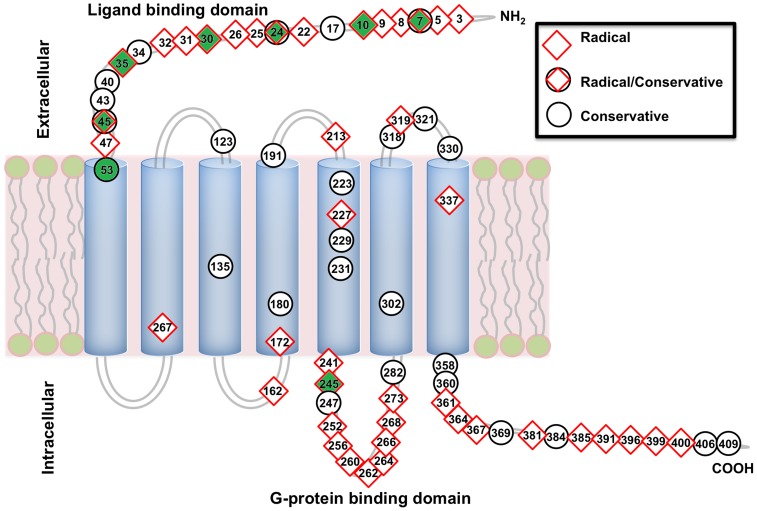
Structural model of AVPR1a.Numbers reflect amino acid substitutions in NWM relative to the human AVPR1a, and radical physicochemical substitutions are indicated by red diamonds and conservative changes by black circles. Potential positively selected sites are highlighted in green.